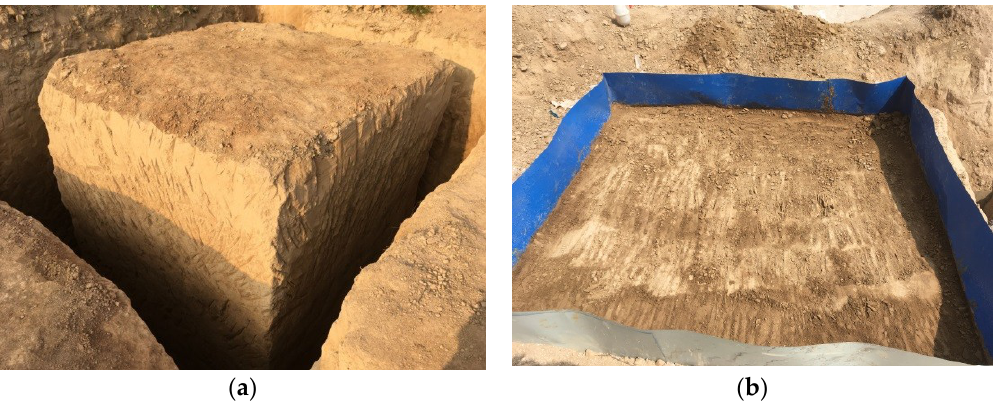
Figure 2. Field infiltration experiment: ( a ) the field soil column; ( b ) water retaining plate at the surface of the soil column.